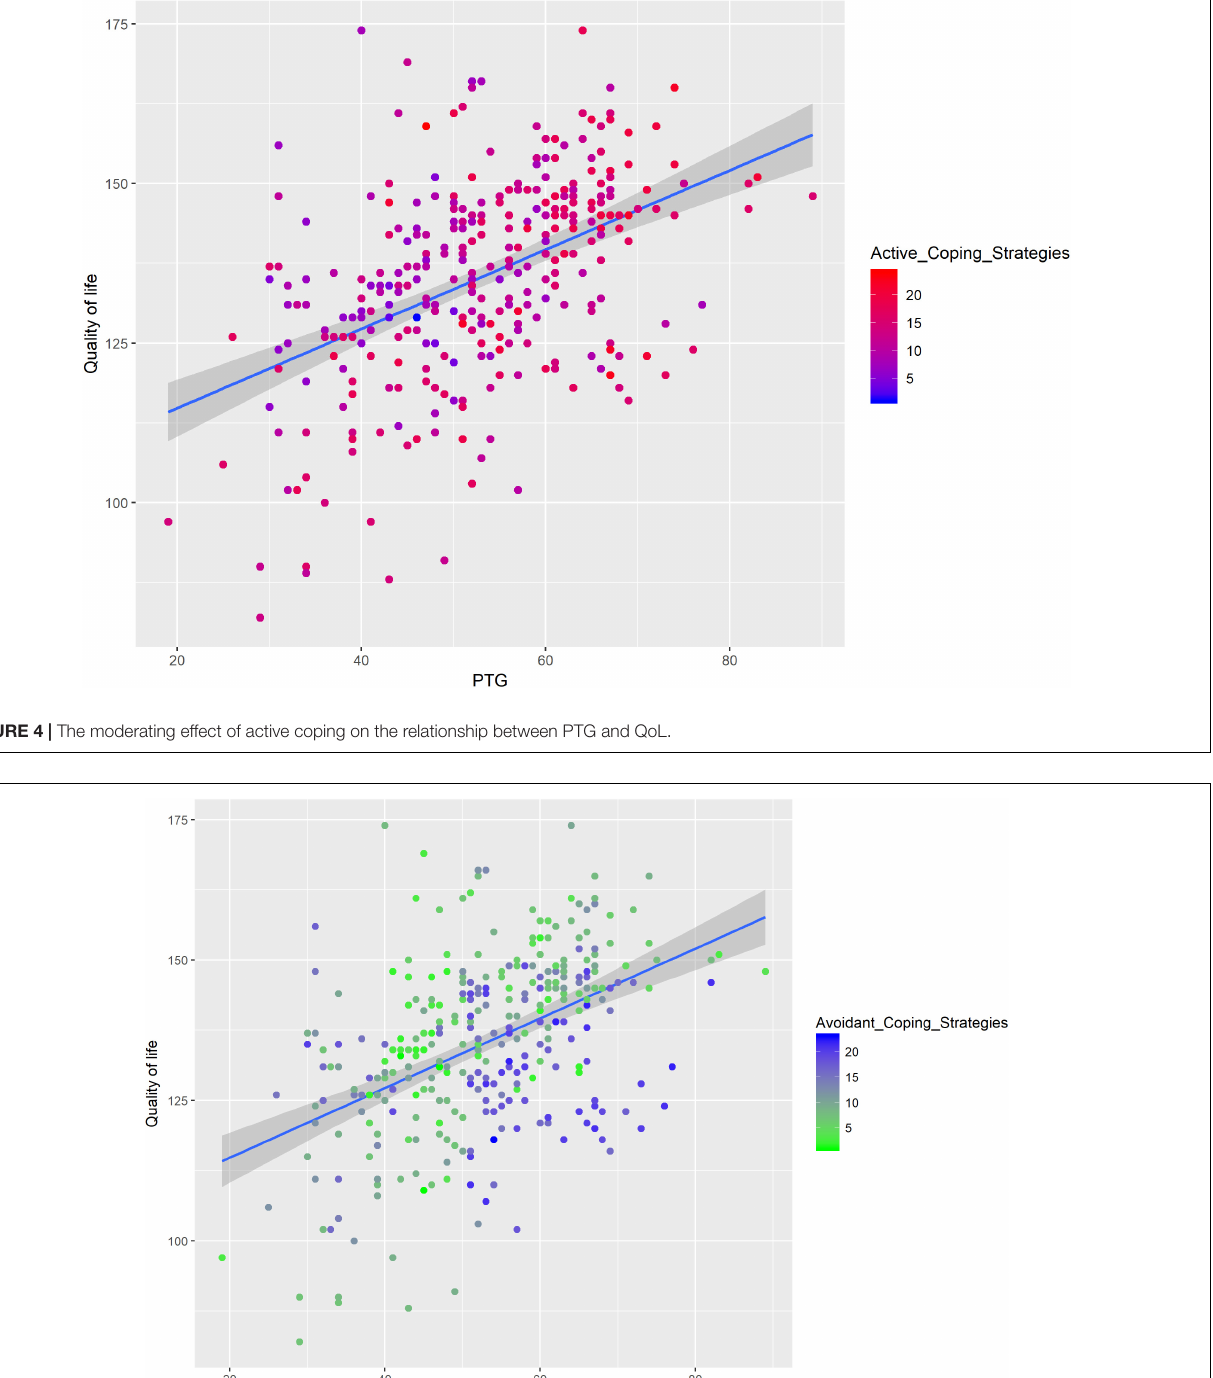
ruminative activity. For some patients (e.g., the patients who have significant PTSD), this ruminative activity was experienced as posttraumatic stress symptoms (Shand et al., 2015), which